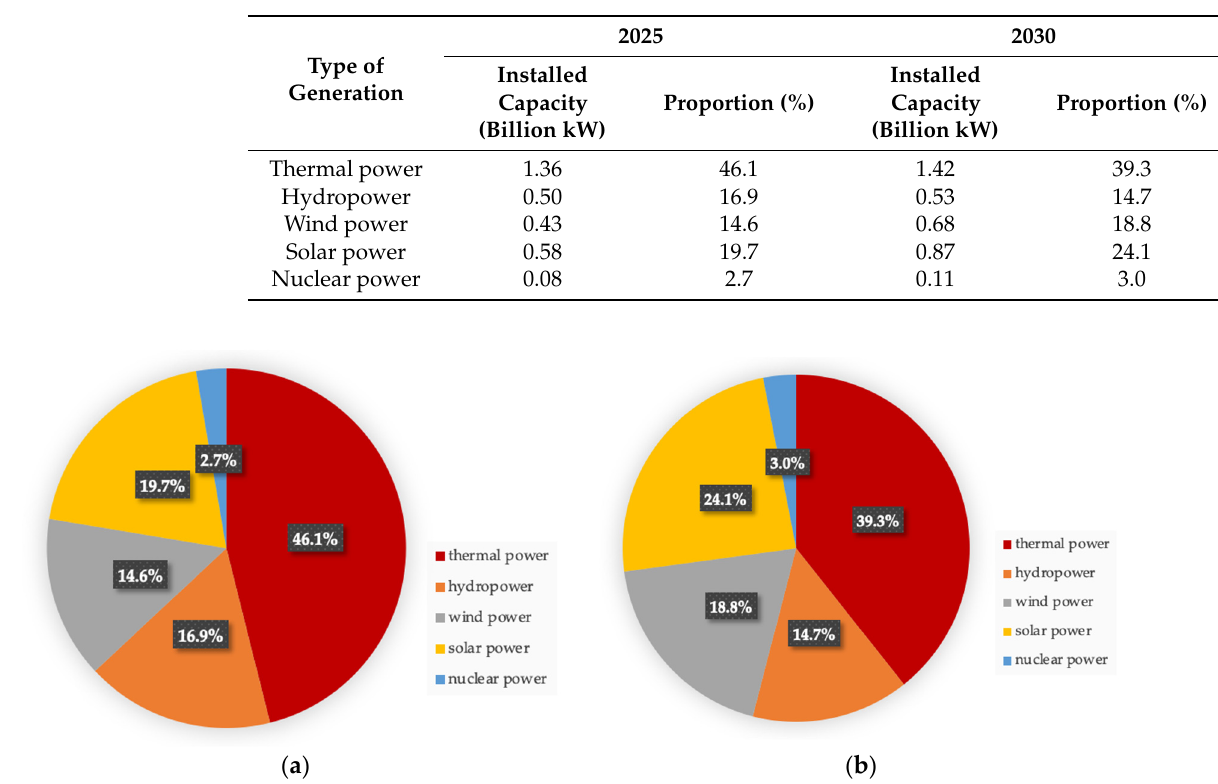
Figure 7. The proportion of installed capacity of various energy sources under the extreme weather condition. ( a ) The projected value for 2025; ( b ) The projected value for 2030.